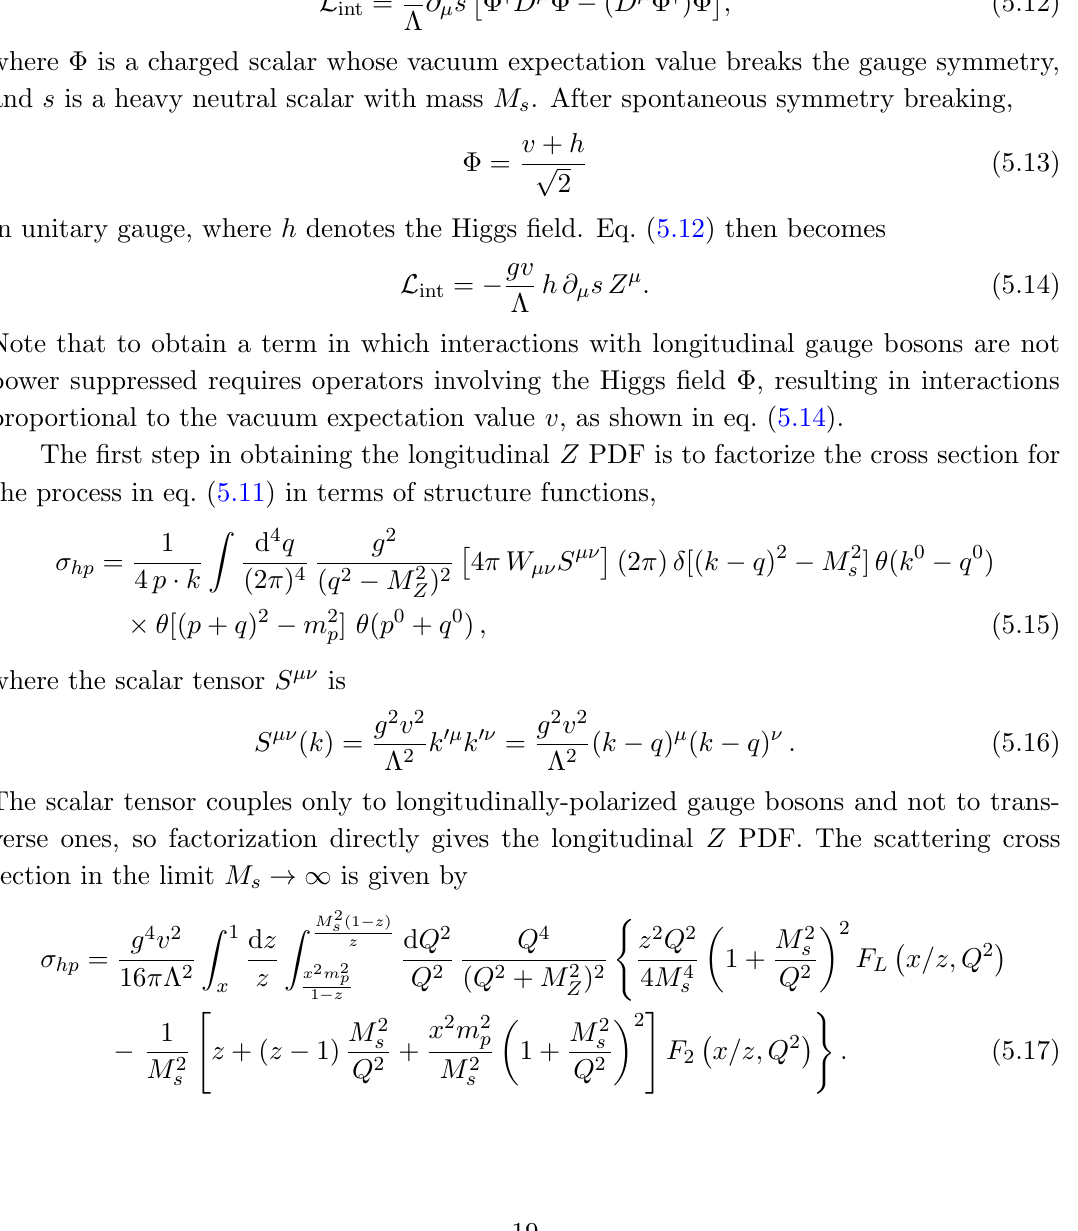
shown in (cid:12)gure 4. Here the interaction between the Z boson and scalars is described